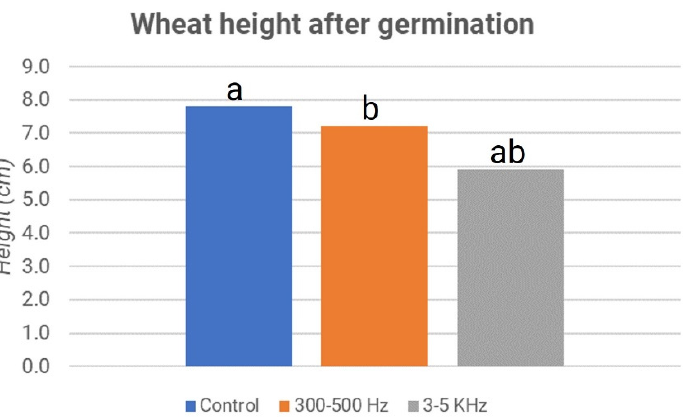
Figure 12. Lentils’ height after germination: third experiment. The letters “a” and “b” refer to the statistical significance of the observed difference between sample couples with a p -value < 0.05 and n = 160.